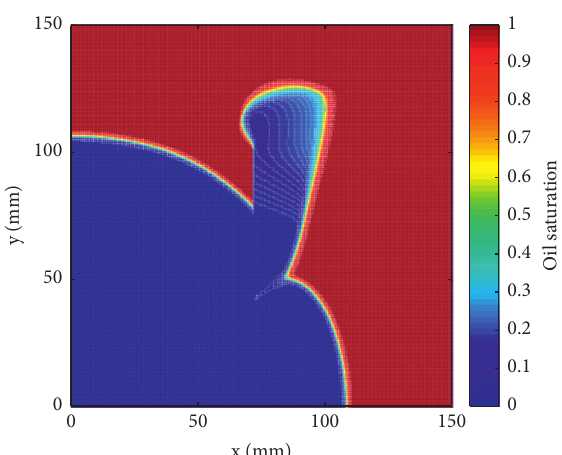
Figure 10: Oil saturation profile for the fine grid simulation after 1800seconds of injection.